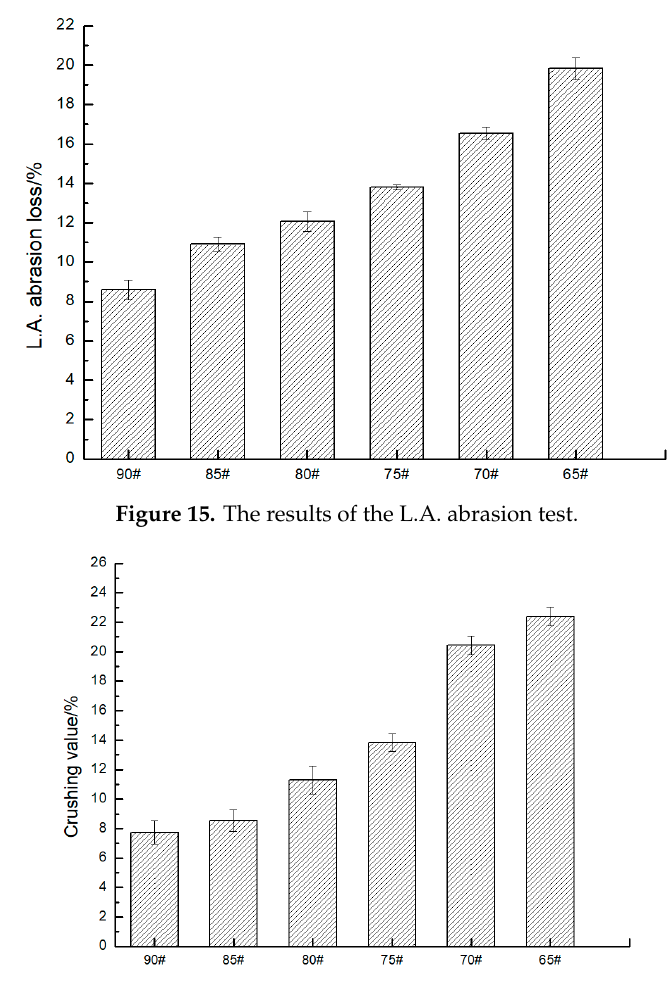
Figure 16. The results of the crushing value test.